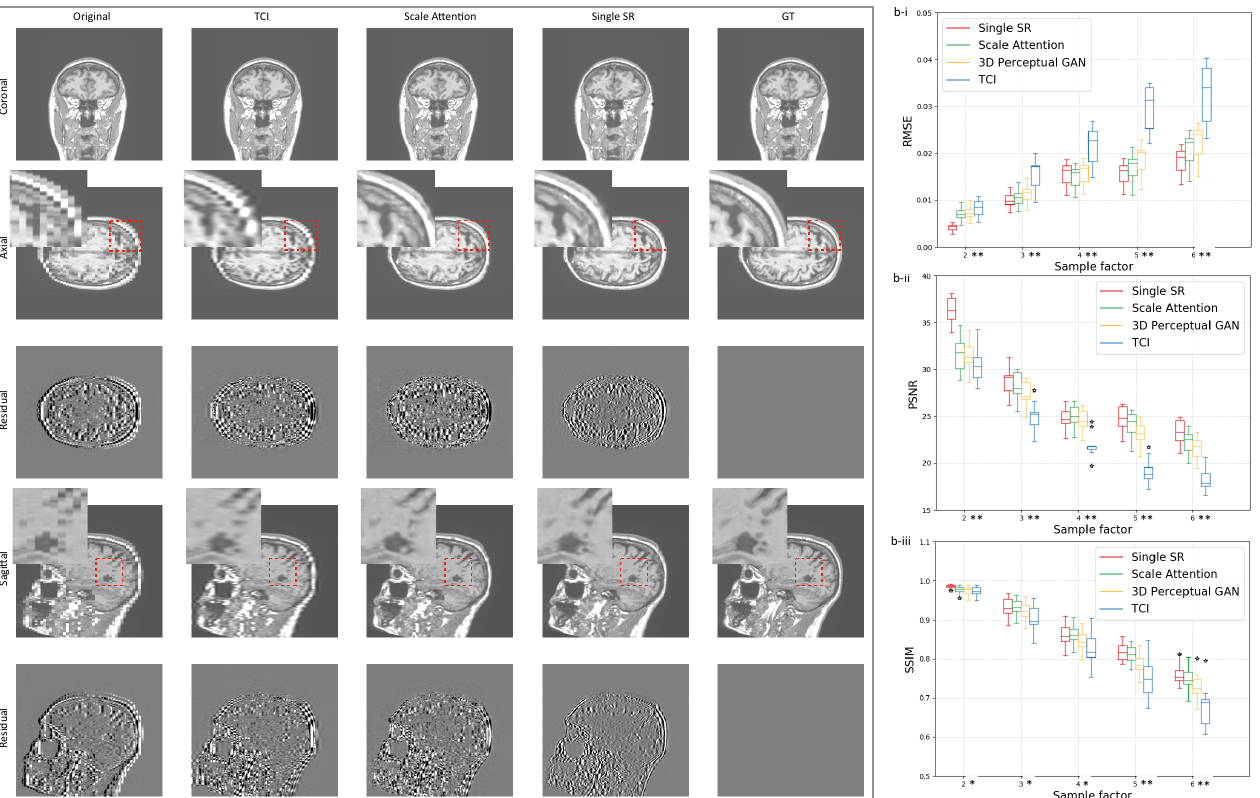
Figure 2. ( a ) Comparison between single-scale model and scale-attention model on T1-weighted brain MRI. The figure shows original slices, cubic interpolation and ground-truth slices as a reference. Residual images at higher contrast are added to better visualize the difference of the generated images to the ground-truths. ( b ) Quantitative comparisons of measures: ( b-i ) RMSE, ( b-ii ) PSNR, and ( b-iii ) SSIM in terms of the sampling factor s between the single-scale model, the scale-attention model, 3D perceptual GAN (SOUP), and cubic interpolation. Statistical significance is indicated on the x-axes with * for p < 0.05 and ** for p < 0.001. TCI: tricubic interpolation; GT: ground